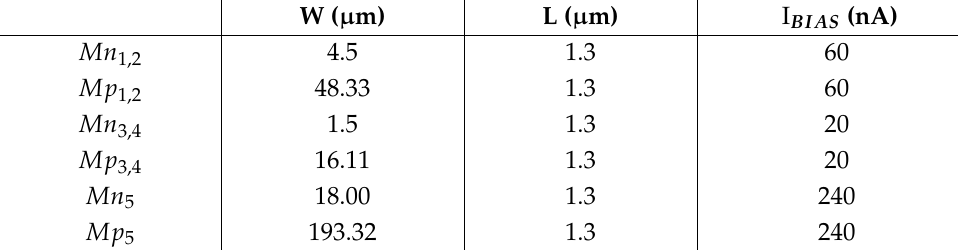
Table 1. Transistors sizing and DC biasing currents of the proposed